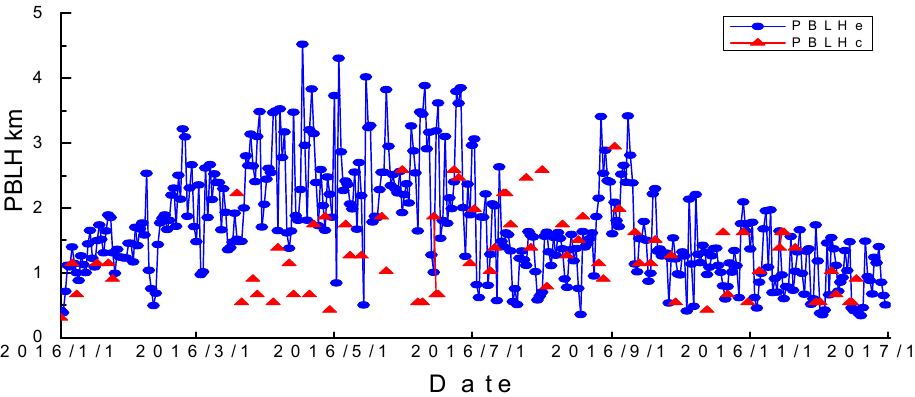
Figure 5. CALIPSO planetary boundary layer height (PBLH) and the European Centre for Medium-Range Weather Forecasts (ECMWF) PBLH of Beijing station in 2016.